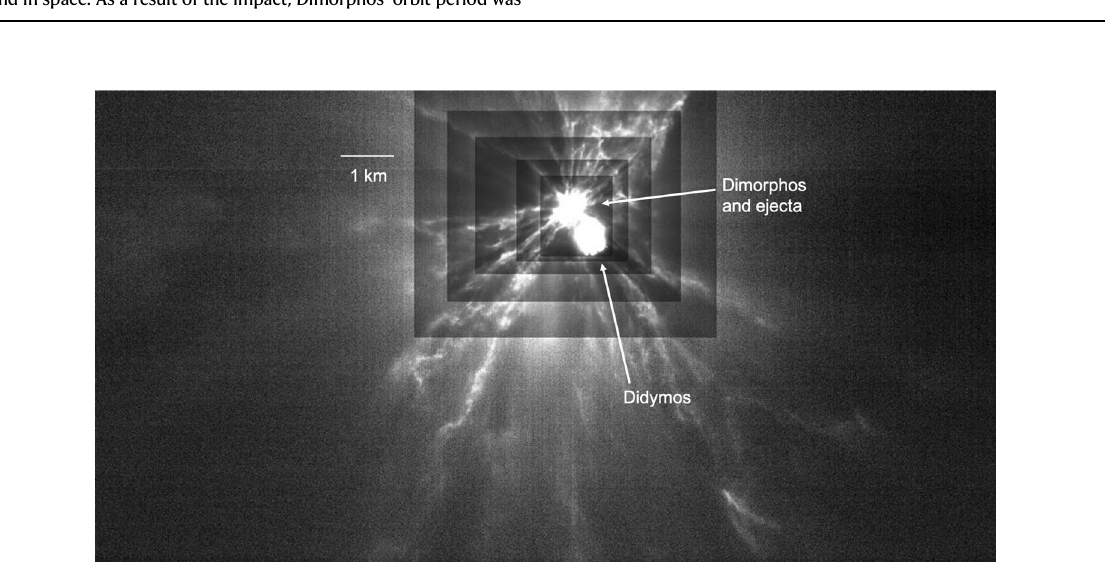
Fig. 1 | Schematic representation of the DART mission. The impact of the DART spacecraftintoDimorphoswasobservedbytheLICIACubeCubeSatandtelescopes at the Earth and in space. As a result of the impact, Dimorphos ’ orbit period was